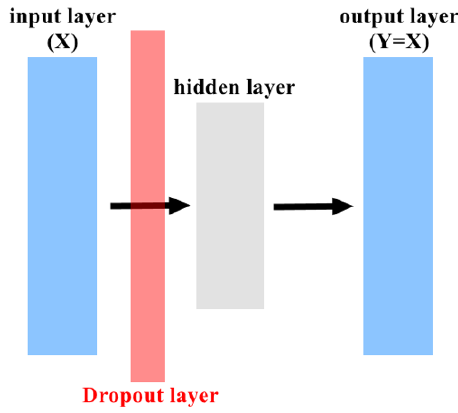
Figure 6. Insert Dropout layer for DAE.